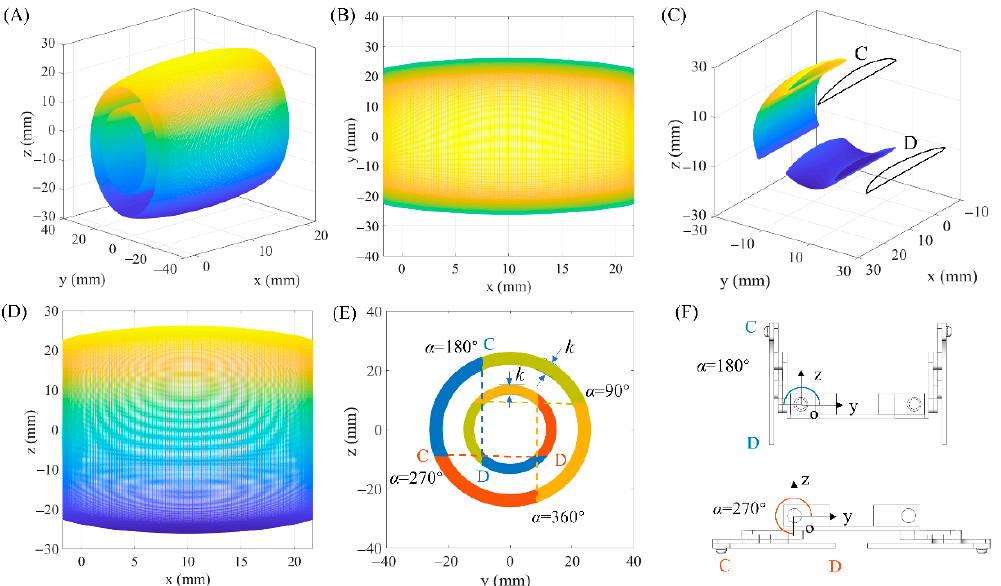
Figure 4. Working space of one leg. ( A ) Work space with two support points C and D, with C on the outside and D on the inside; ( B ) projection of the working space on the x–o–y plane; ( C ) cross section of working space; ( D ) projection of the working space on the x–o–z plane; ( E ) projection of the working space on the y–o–z plane, and the working space position corresponding to the typical robot structure; ( F ) Two typical postures of crawling robot ( α = 180 ◦ and α = 270 ◦ ). The working space contains the reachable space of two supporting points C and D,